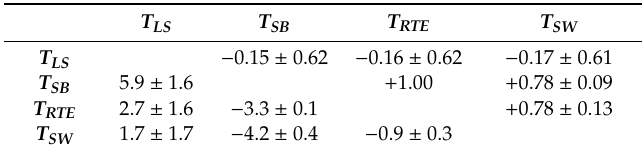
Table 2. Relation among contemporary tile average temperatures obtained by di ff erent methods under the same meteorological